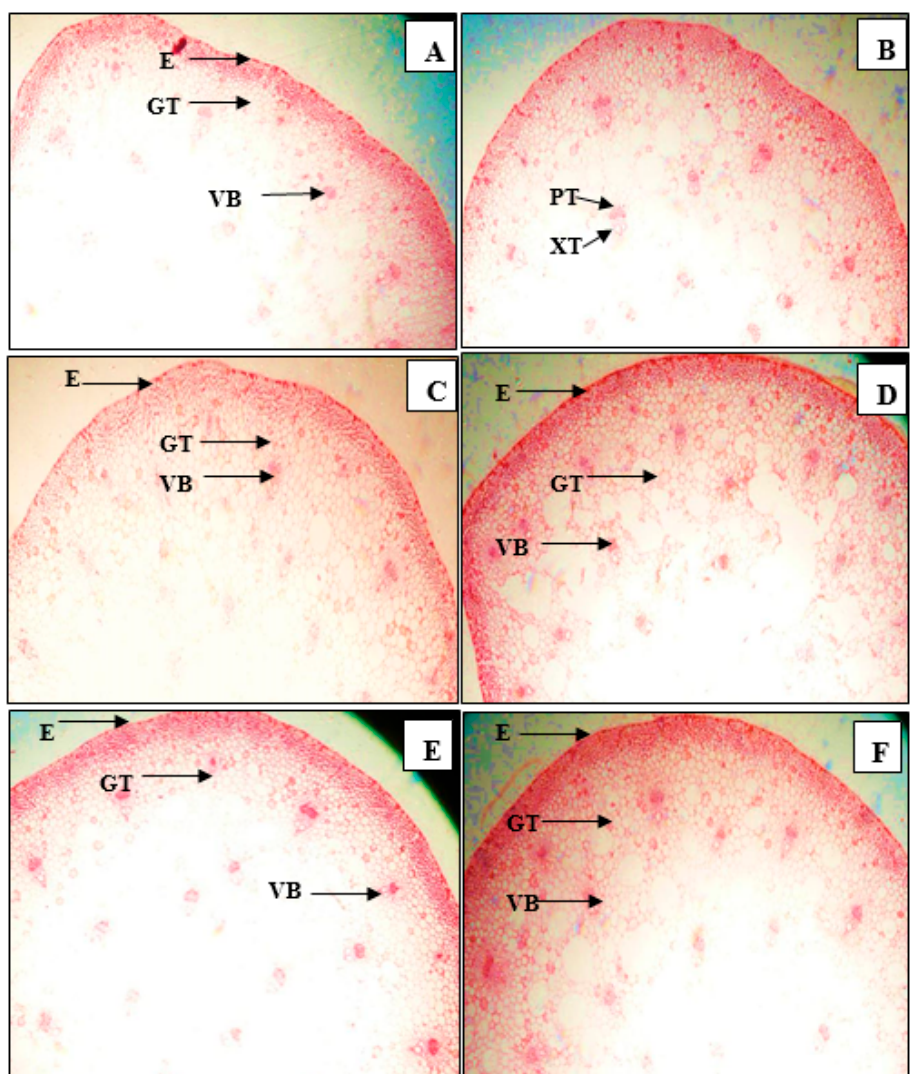
Figure 6. Anatomical structure of Philodendron bipinnatifidum stems in the second season. ( A ): control, ( B ): NPK NPs at 2 ml/L, ( C ): ZnNPs at 200 mg/L, ( D ): SNPs at 20 mg/L, ( E ): SNPs at 40 mg/L, ( F ): SNPs at 60 mg/L, E: Epidermis, GT: Ground tissue, VB: Vascular bundle, XT: Xylem tissue, PT: Phloem tissue (Magnification 100×).